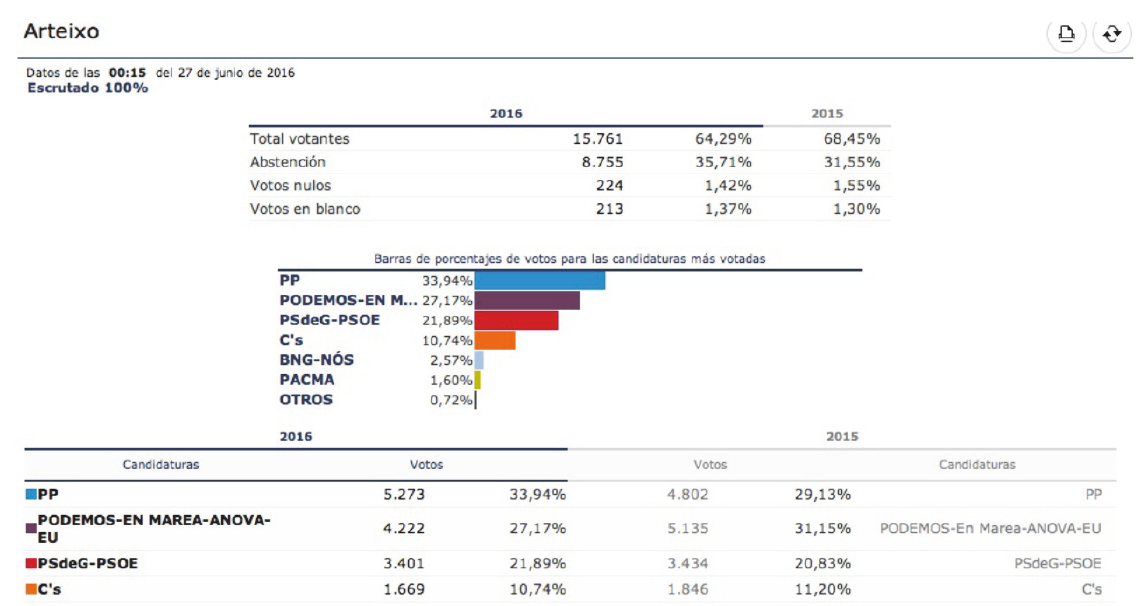
Figure 1: Sample municipality (Arteixo) along with vote count statistics, as reported in the Ministerio del Interior official webpage